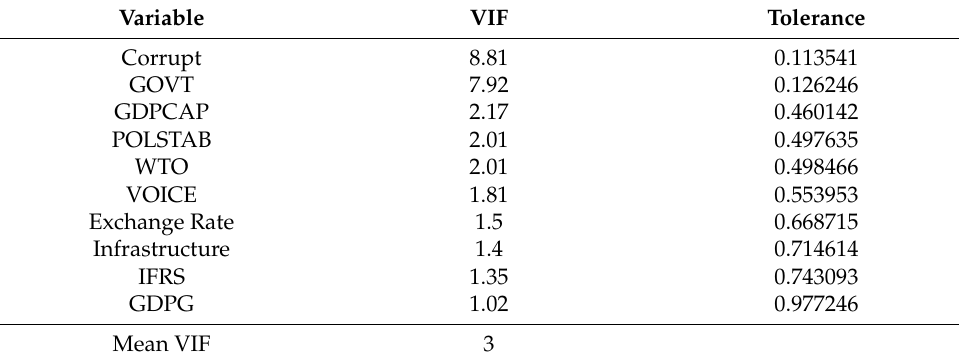
Table A4. Results of Variance Inflation Factor (VIF).